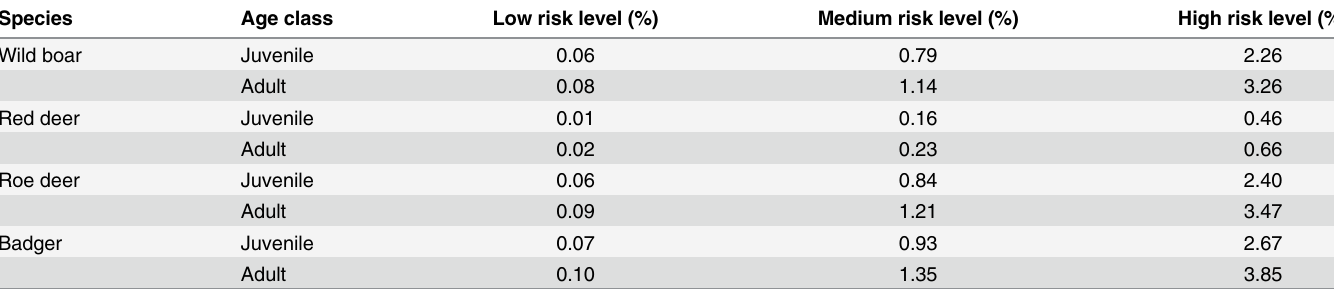
Table 2. Probability of infection in scenario trees according to species, age class and geographic risk.